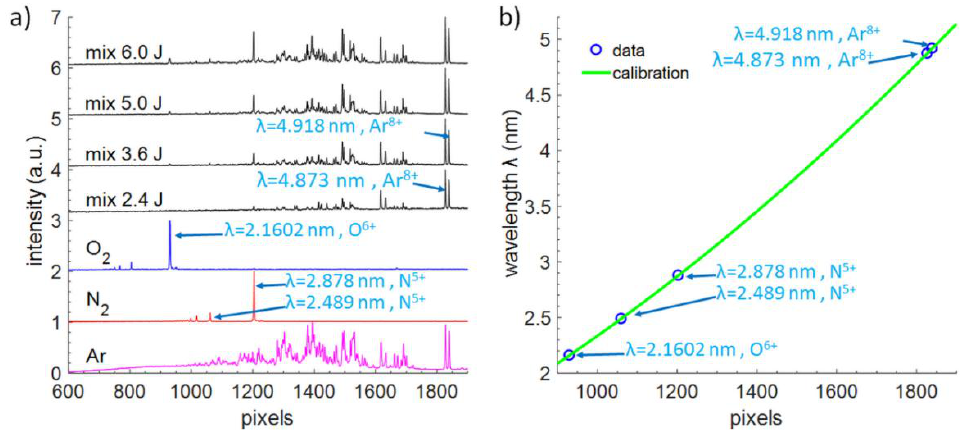
Figure 3. SXR spectrometer calibration. SXR spectra ( a ) of the pure gasses (three bottom plots) and a 1:1:1 (by volume) of Ar, N 2 , and O 2 gasses for different energies of the laser pulses. A mixture (mix) is more convenient to perform calibration and allows one to see all lines of interest, later used to obtain a spectrometer calibration curve, depicted in Figure ( b